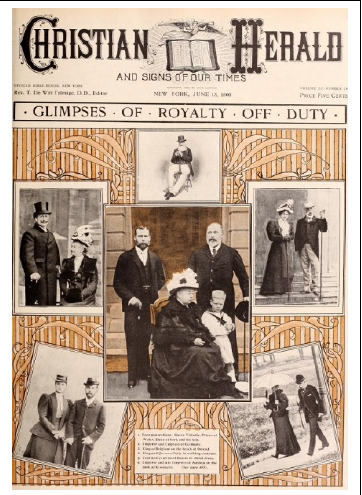
Figure 2. Glimpses of Royalty Off Duty. The Christian Herald , June 13, 1900.